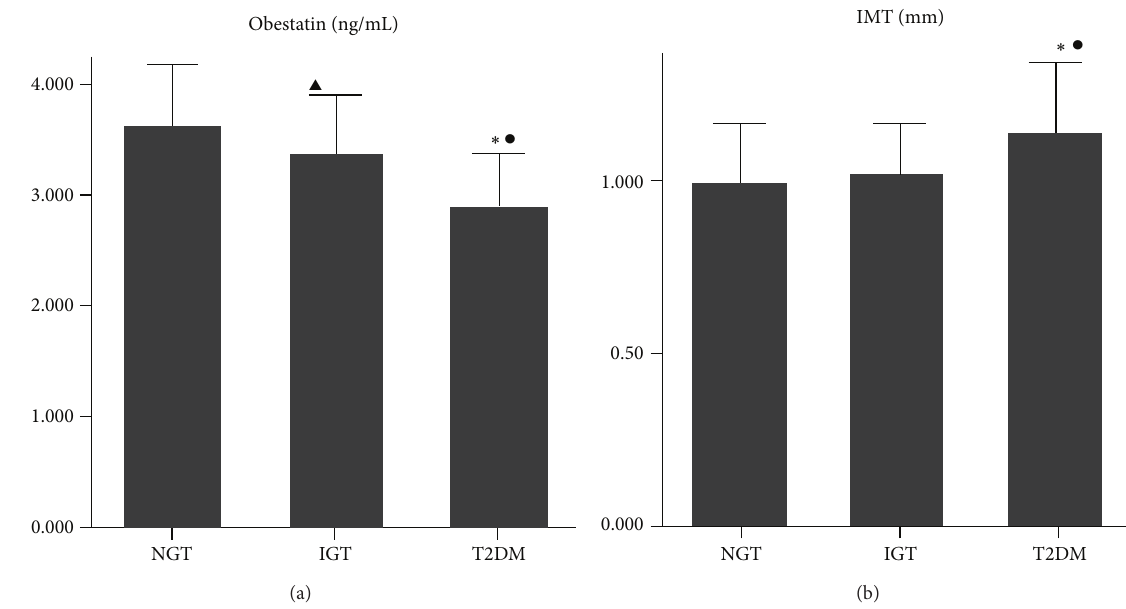
Figure 1: Levels of obestatin (a) and IMT (b) in patients of NGT, IGT, and T2DM groups. 󳵳 : 𝑃 < 0.05 compared with NGT group (the control group), ∗ : 𝑃 < 0.01 compared with NGT group, ∙ : 𝑃 < 0.01 compared with IGT group, and IMT: intima-media thickness.